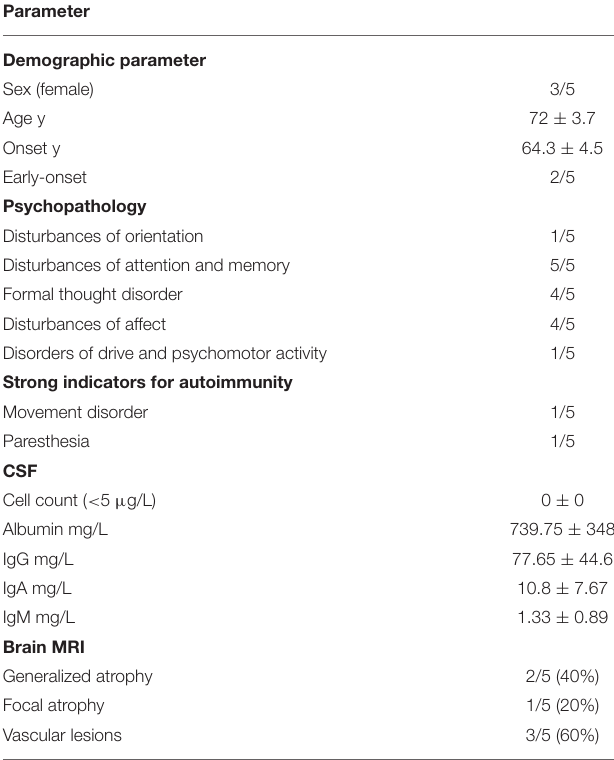
TABLE 1 | Clinical characterization of patients.